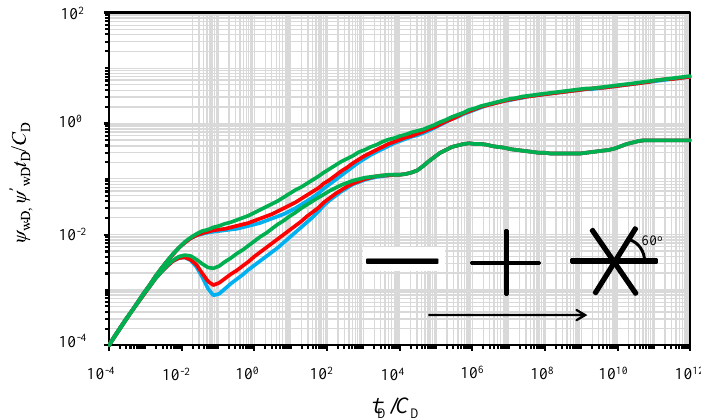
Figure 12. Effect of the number of hydraulic fracture wings on the PPR and PPD.